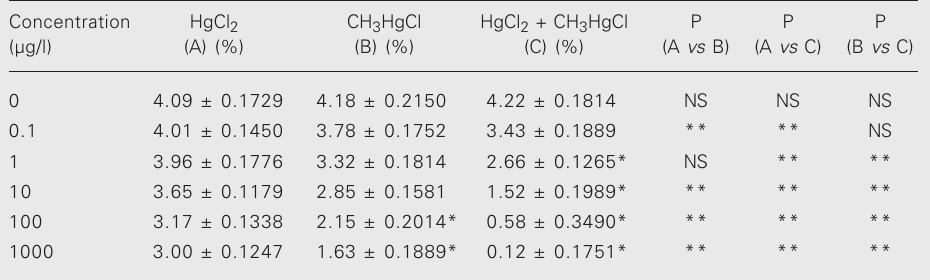
Table 2. Relative frequency of cells with gaps, breaks and gaps plus breaks after exposure to mercury chloride and methylmercury chloride.